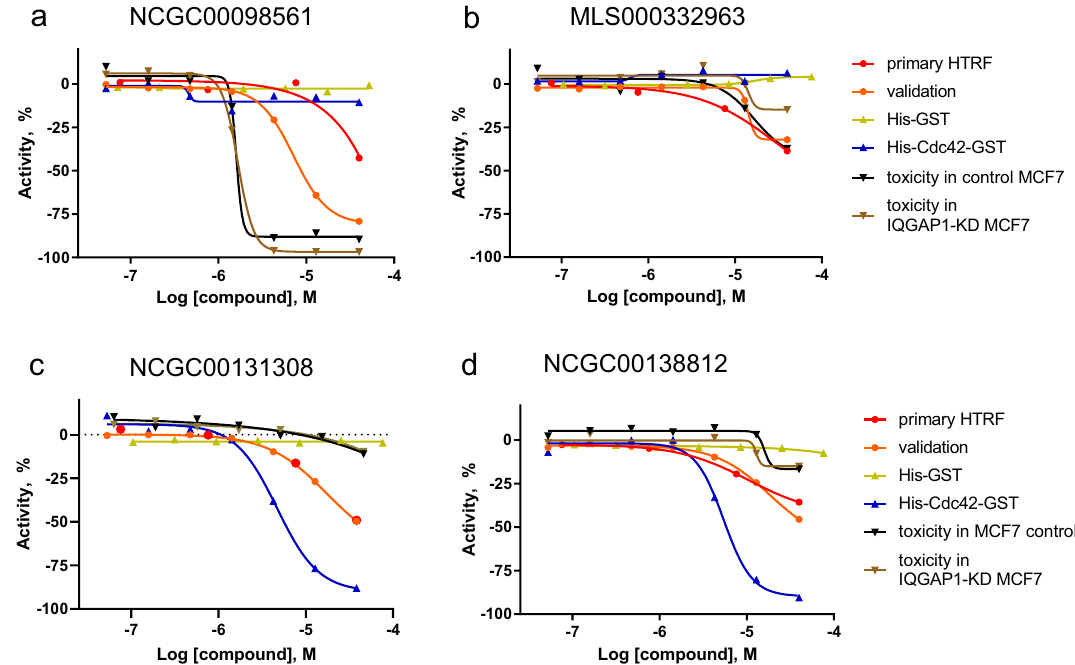
Figure 4. Dose responses of four selected compounds in HTRF, counter-screen and cytotoxicity assays. ( a ) NCGC00098561, ( b ) MLS000332963, ( c ) NCGC00131308 and ( d ) NCGC00138812. Primary HTRF—primary HTRF high-throughput screening; validation—confirmatory HTRF assay; His-GST—counter-screen with His- GST; His-Cdc42-GST—counter-screen with dual-tagged Cdc42; toxicity in control MCF7—cytotoxicity assay in control MCF7 cells; toxicity in IQGAP1-KD MCF7—cytotoxicity assay in IQGAP1-KD MCF7